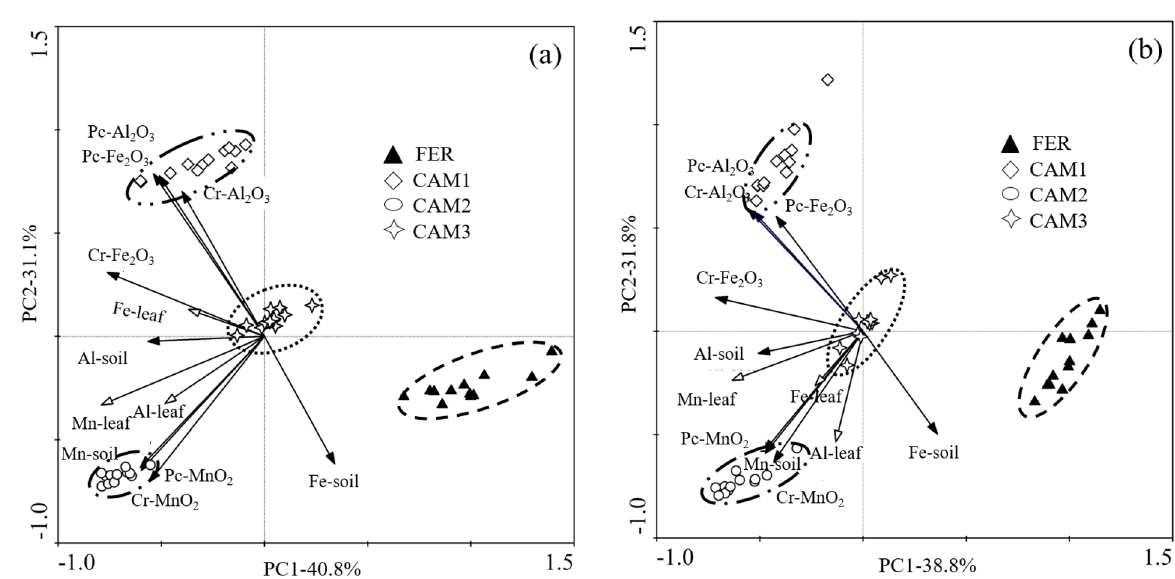
Figure 3 - Principal component analysis of Mn, Fe and Al in the leaves of clones ( a : Clone 1, b : Clone 2) of yerba mate and Mn, Fe and Al (soil: available; Pc: poor crystalline forms; Cr: crystalline forms) in four acid soils. FER - Ferralsol; CAM - Cambisol. PC: principal